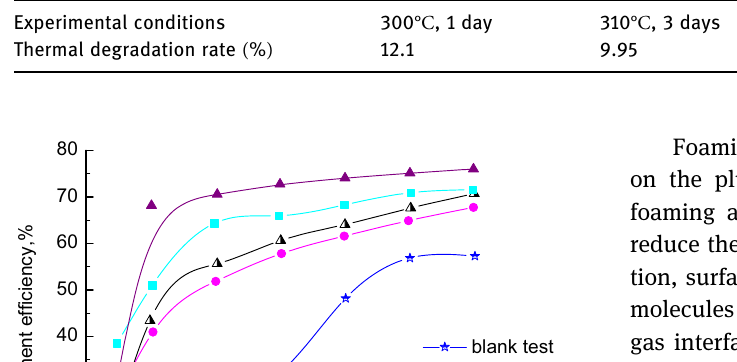
Table 1: Indicators of high - temperature endurance performance of the foaming agents Name of foaming agent